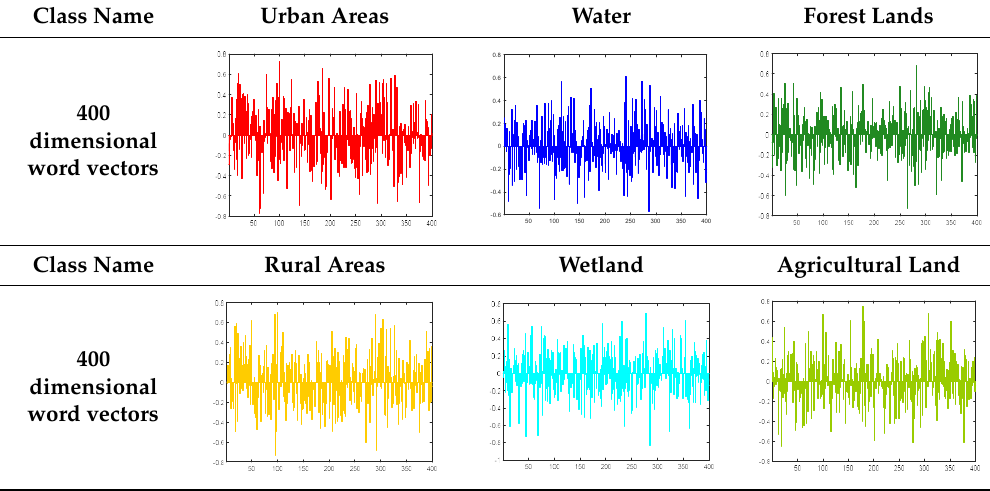
Table 1. The examples of the land cover class and the corresponding word vectors.